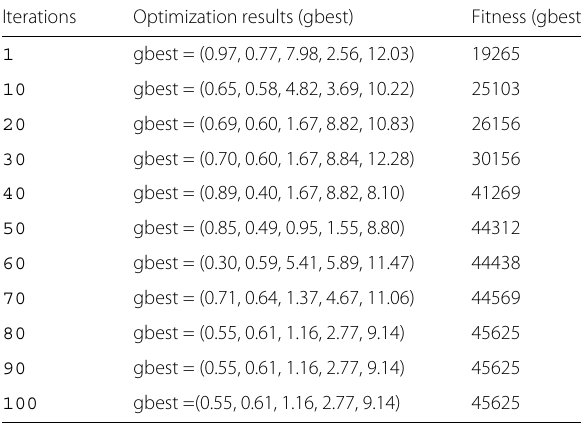
Table 1 The iteration result of PSO for the training